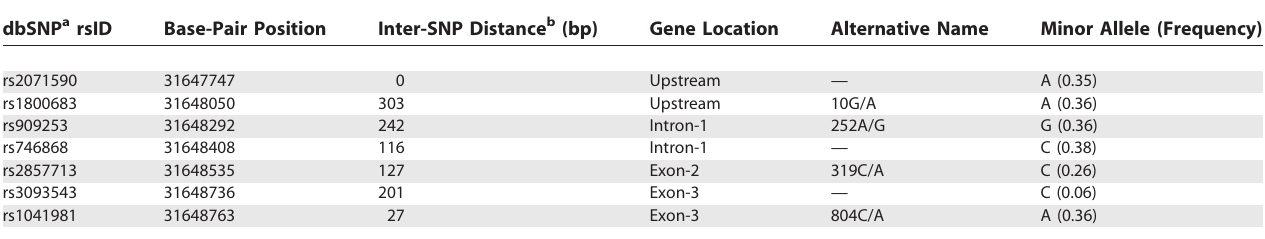
Table 1. Identity and Base-Pair Position of SNPs for the LTA Gene on Chromosome 6, and Minor Allele Frequencies in Controls in the ISIS